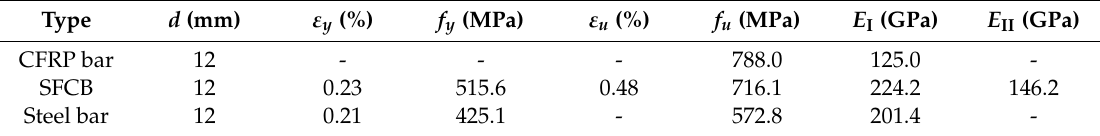
Figure 3. Experimental reinforcement: ( a ) carbon fiber reinforced polymer (CFRP) bar, ( b ) steel fiber reinforced polymer composite bar (SFCB). Table 2. Mechanical properties of the experimental reinforcements.